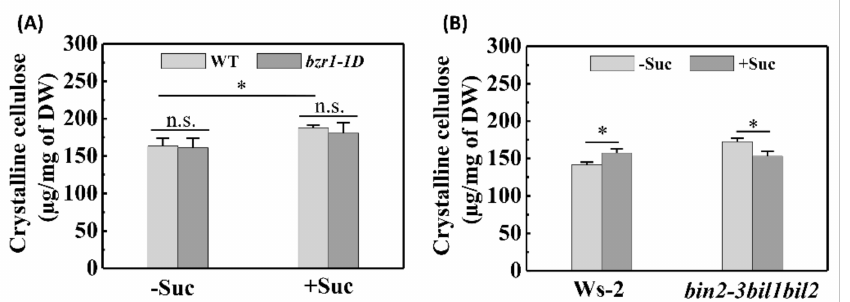
Figure 6. Measurements of crystalline cellulose content. ( A ) Crystalline cellulose contents of 5-day- old wild-type (WT) and bzr1-1D etiolated seedlings. ( B ) Crystalline cellulose contents of 5-day-old Ws-2 and bin2-3bil1bil2 etiolated seedlings. Seedlings shown in both ( A , B ) were grown on medium with or without 30 mM sucrose. Values are presented as the means ± SD of three independent sets of experiments. Data were statistically evaluated using Student’s t -test, and the significance of differences (*, p < 0.05; n.s., not significant) is